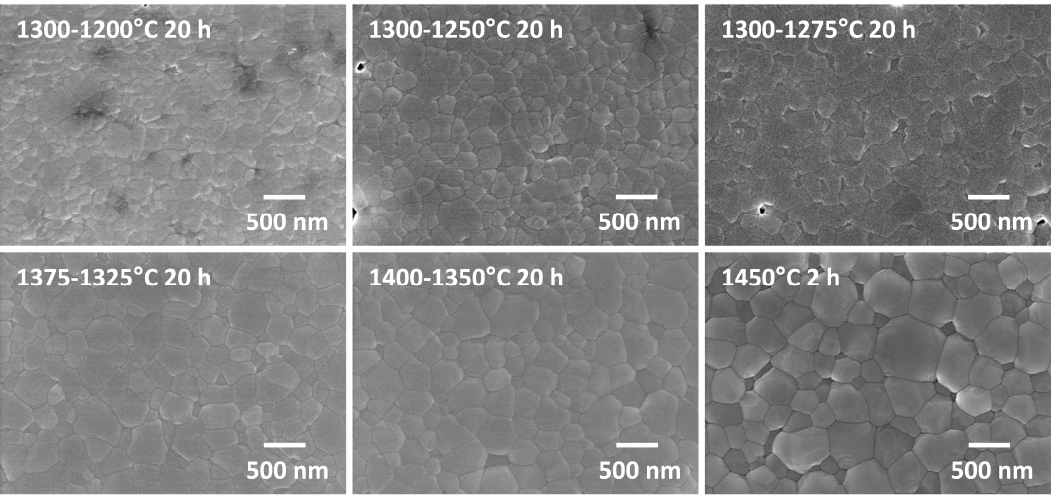
Figure 8. SEM micrographs of two-step sintered samples prepared from as-received powder. The temperatures in each label are T1 and T2 respectively.